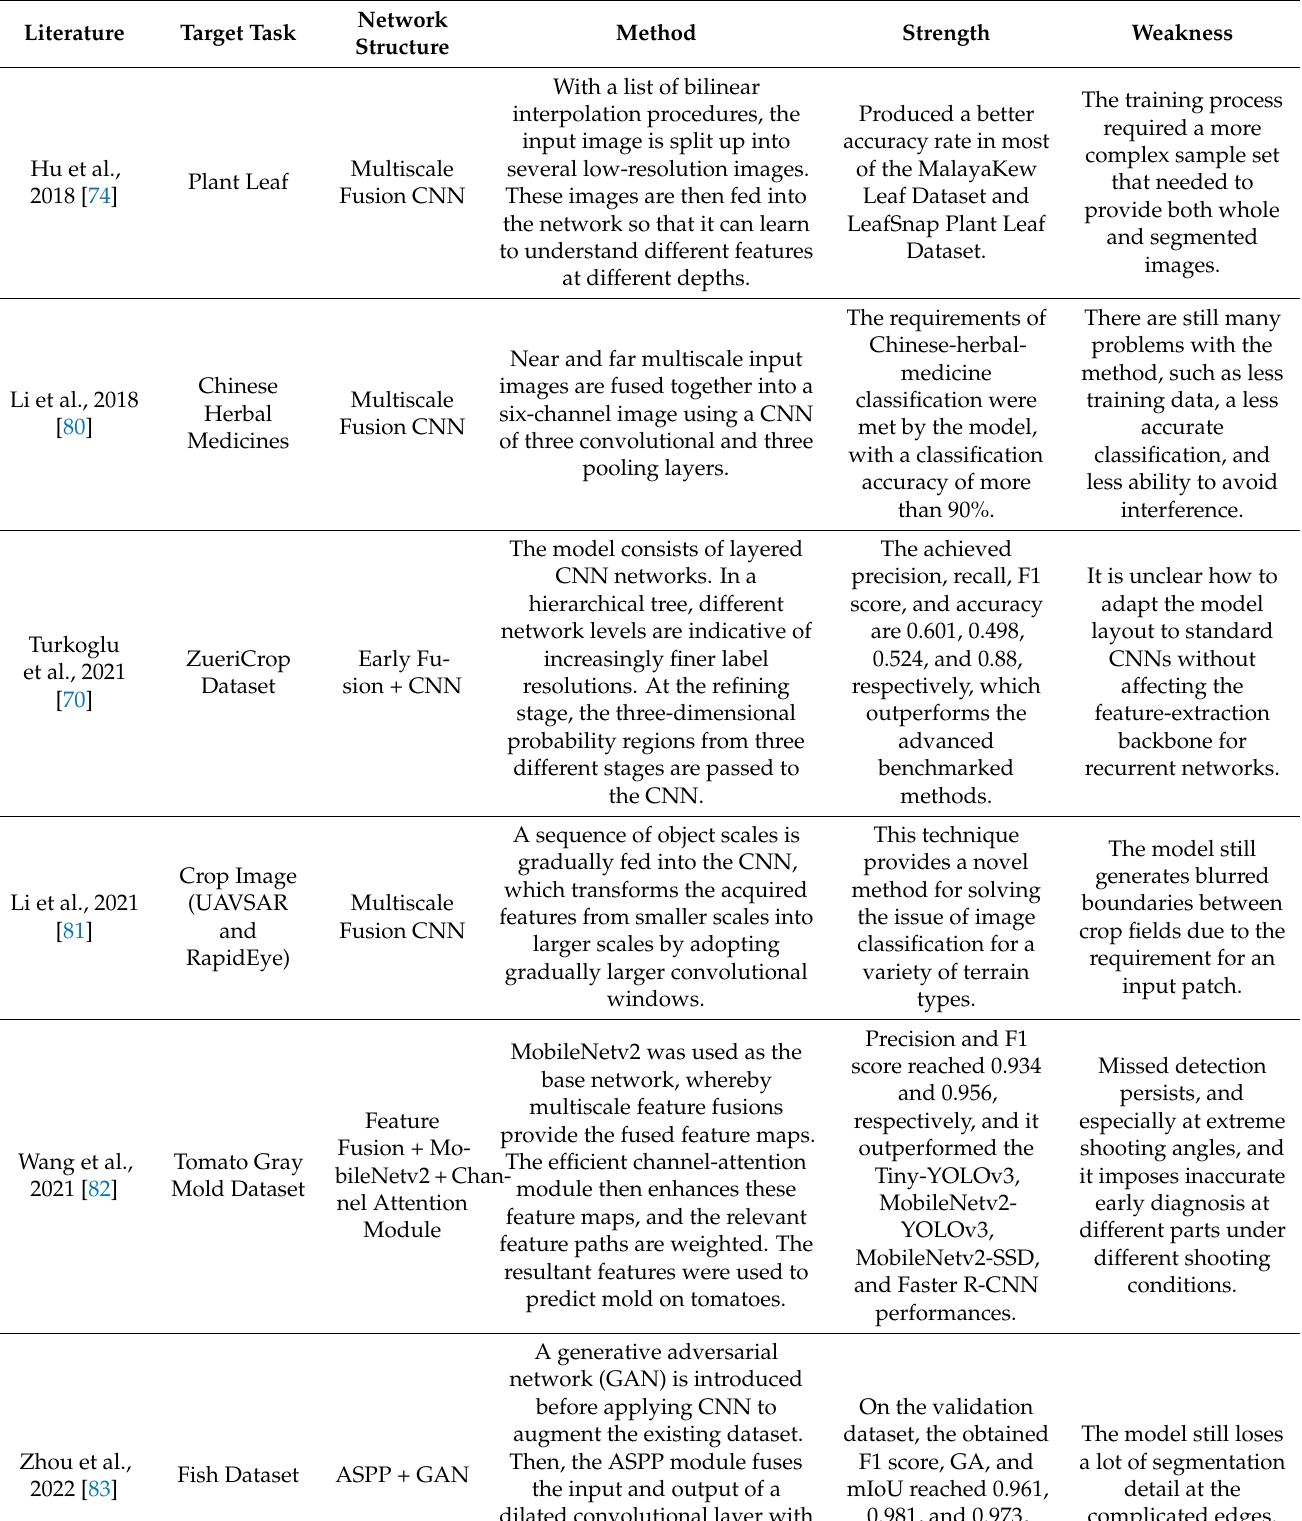
Table 3. The Application of Multiscale Deep Learning in Agriculture